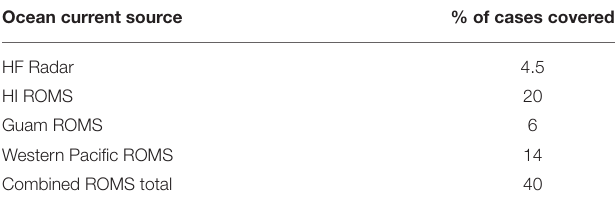
TABLE 1 | Percentage of SAR cases covered by available ocean current data sources. Ocean current source % of cases covered